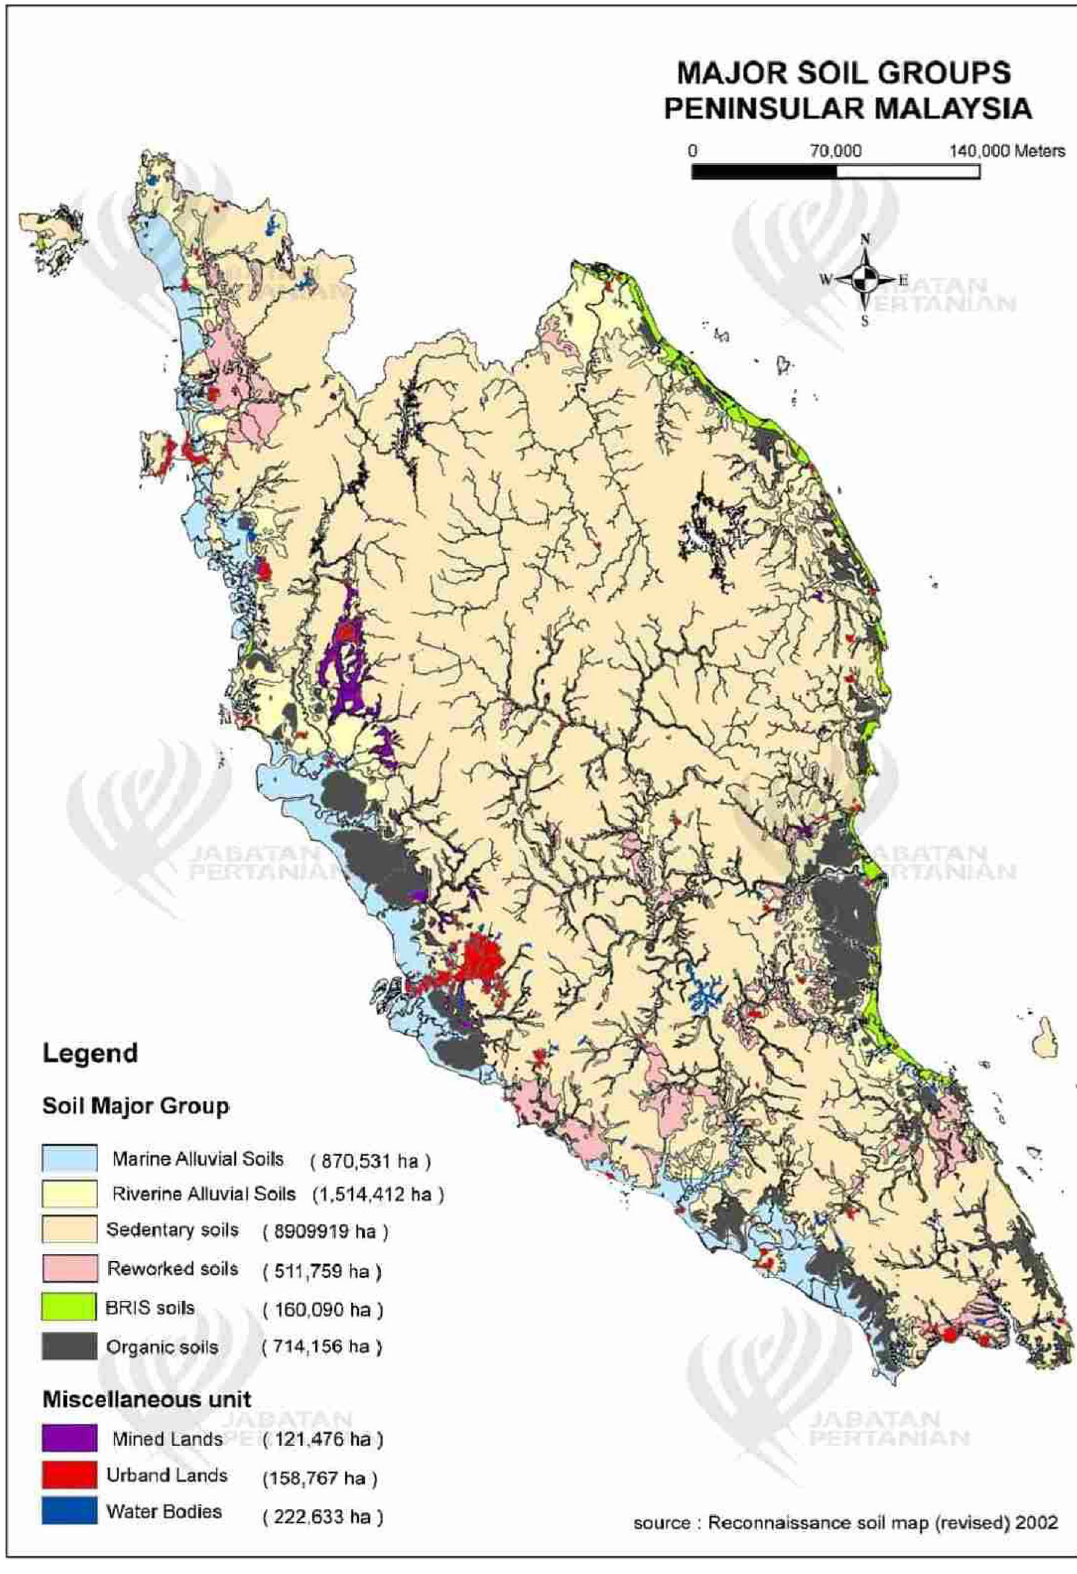
Figure 1. The extent of sandy soils distributions in Peninsular Malaysia 70